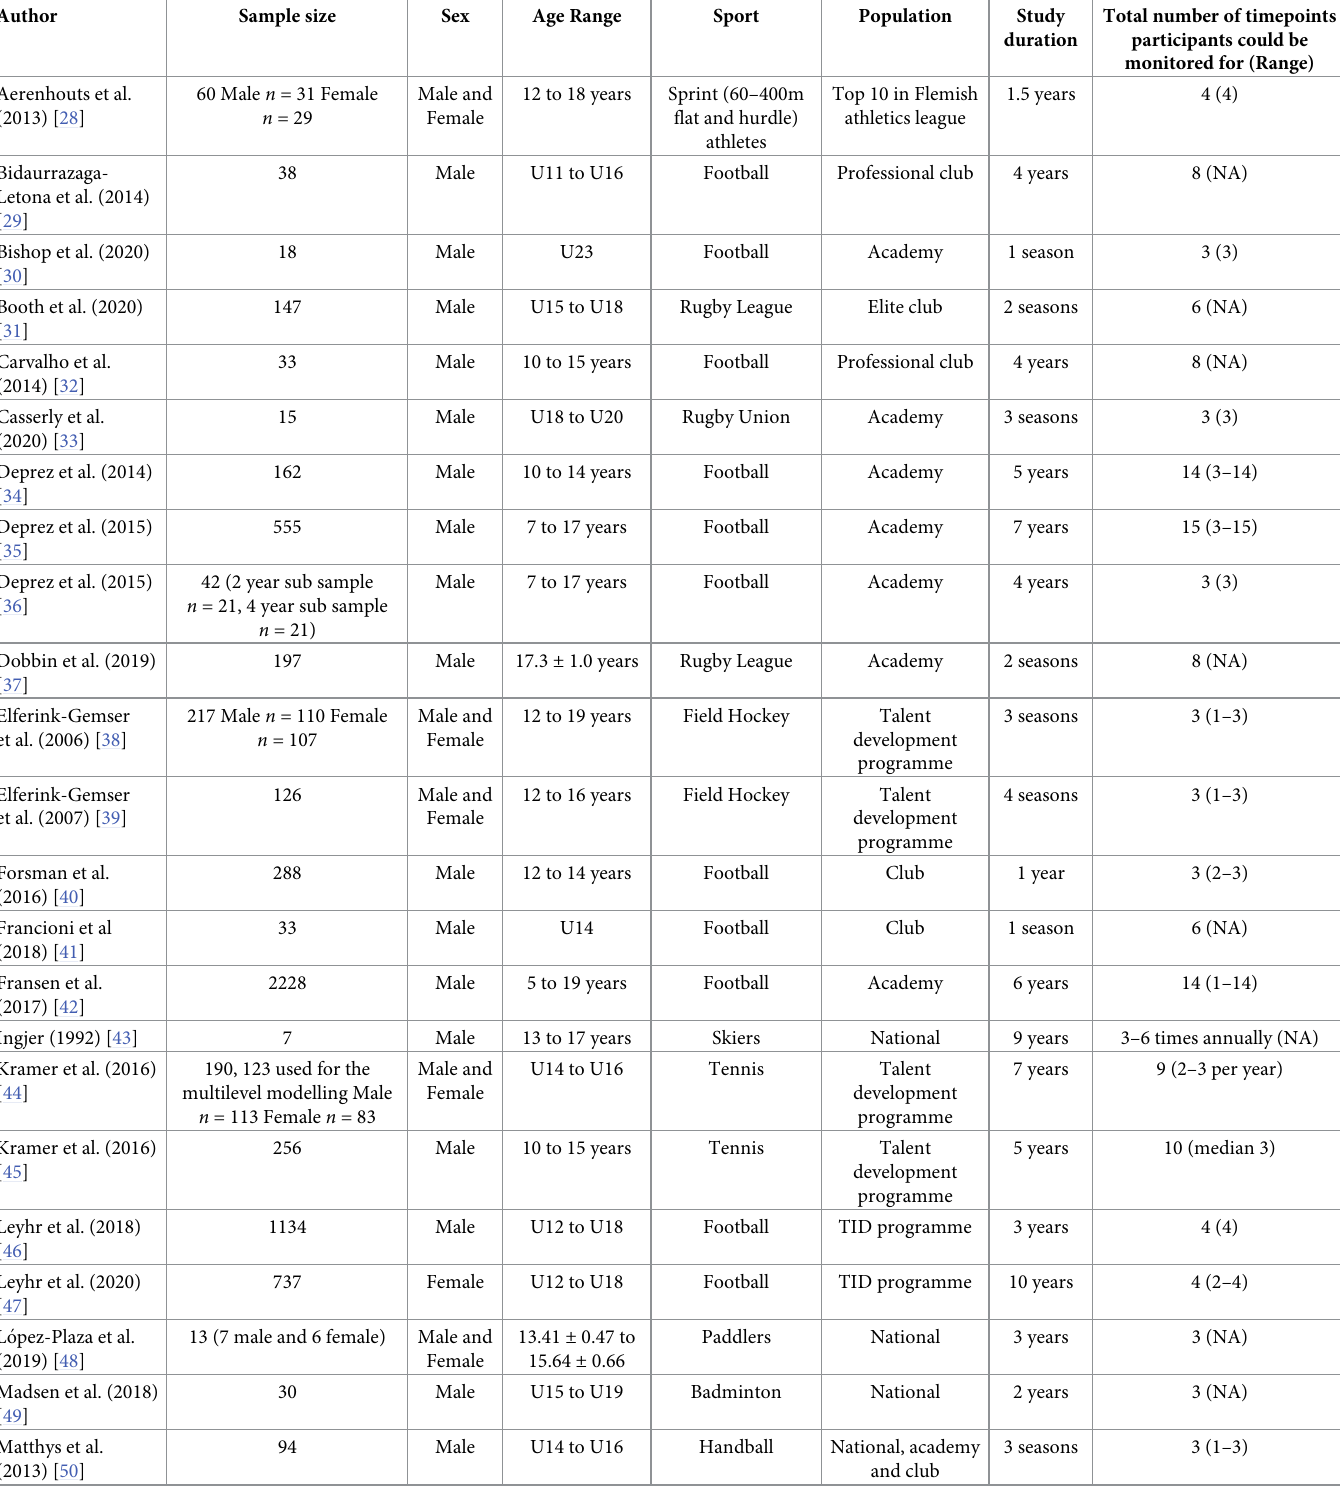
Table 2. Summary of articles that investigated longitudinal fitness testing